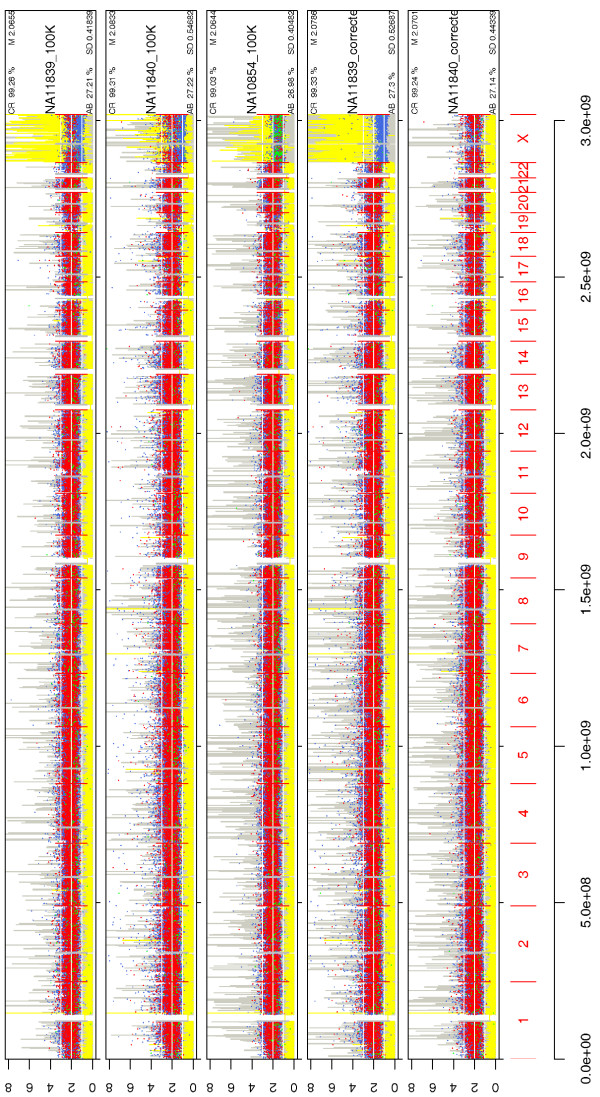
SNPscan result for three apparently normal individuals using 100 K data. SNPscan was used to analyze 100 K SNP data, combined from Affymetrix's 50 K Hind and 50 K Xba via CNAT v2.0. The first three tracks are a trio (father, NA11839; mother, NA11840; daughter, NA10854). Note that for both of the first two tracks, the patterns observed on the X chromosome are atypical. The first two tracks show a unique and apparently abnormal pattern of red dots in the copy number range that is normal for females (1–3), with blue dots exposed in a lowered copy number range that is normal for males (1–2). The p values (yellow area) for the first track are much higher than that of the second track, presumably because of the smaller number of heterozygous calls derived from the Hind array (see Table 3). Together, these observations suggest a pattern of SNPs that represents a combined male and female profile; our interpretation is that the labels were switched on two of the Hind datasets (see Table 3). The third track, showing data on an apparently normal female, has another pattern: many red and green dots mostly in the copy number range of 1 to 2.5, with p values (yellow) intermediate between normal female and male values. This represents a female with a mosaic loss of the X chromosome. After the labeling error was corrected for the first two tracks, the results (NA11839 as male and NA11840 as female) were plotted in the last two tracks.